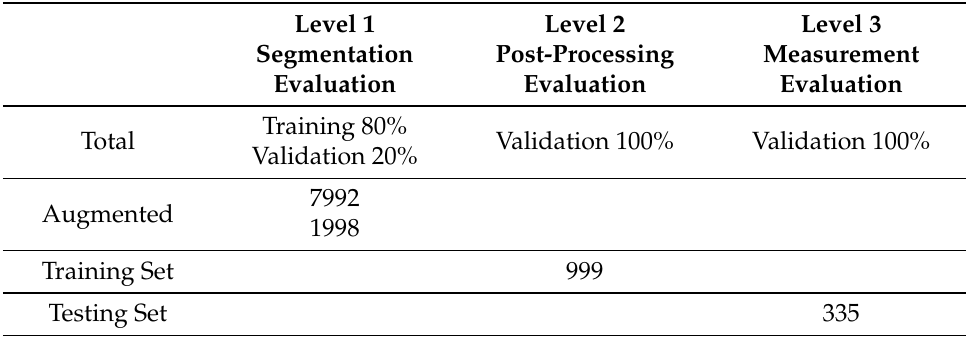
Table 6. Evaluation levels for segmentation